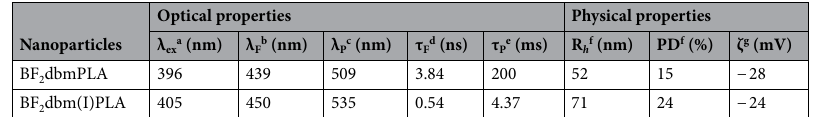
Table 1. Nanoparticle characteristics. a Absorption maxima. b Fluorescence emission maxima excited at 369ˆnm. c Phosphorescence maxima in the delayed emission spectrum excited at 369 nm with a 0.5 ms delay. d Fluorescence lifetime monitored at the emission maximum. e Phosphorescence lifetime monitored at the phosphorescence maximum. f Hydrodynamic radius and polydispersity (PD) determined by dynamic light scattering. g Zeta potential measured by ZetaSizer.